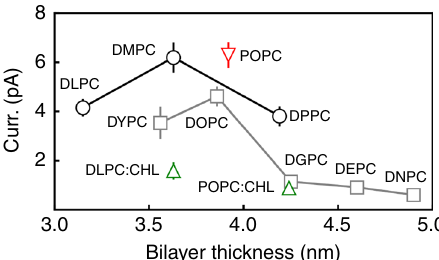
Fig. 2 Effects of lipid – protein interactions on ion permeation through MthK. Ion currents are shown as a function of membrane thickness. Ion currents of MthK in membranes composed of saturated (DLPC, n = 40; DMPC, n = 30; DPPC, n = 40), unsaturated (DYPC, n = 20; DOPC, n = 40; DGPC, n = 25; DEPC, n = 20; DNPC, n = 10), and hybrid lipids (POPC, n = 40), and cholesterol-containing membranes (DLPC:CHOL, n = 30; POPC: CHOL, n = 10) are shown in black, gray, red, and green symbols, respectively. n indicates the number of simulation replicates. Data are presented as mean values ± SEM. Source data are available as a Source Data fi